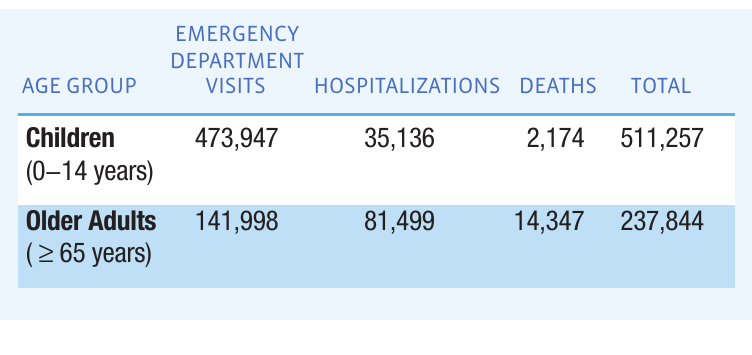
TABLE B: Estimated Average Annual Numbers of Traumatic Brain Injury-Related Emergency Department Visits, Hospitalizations, and Deaths, by Age Group, United States, 2002–2006